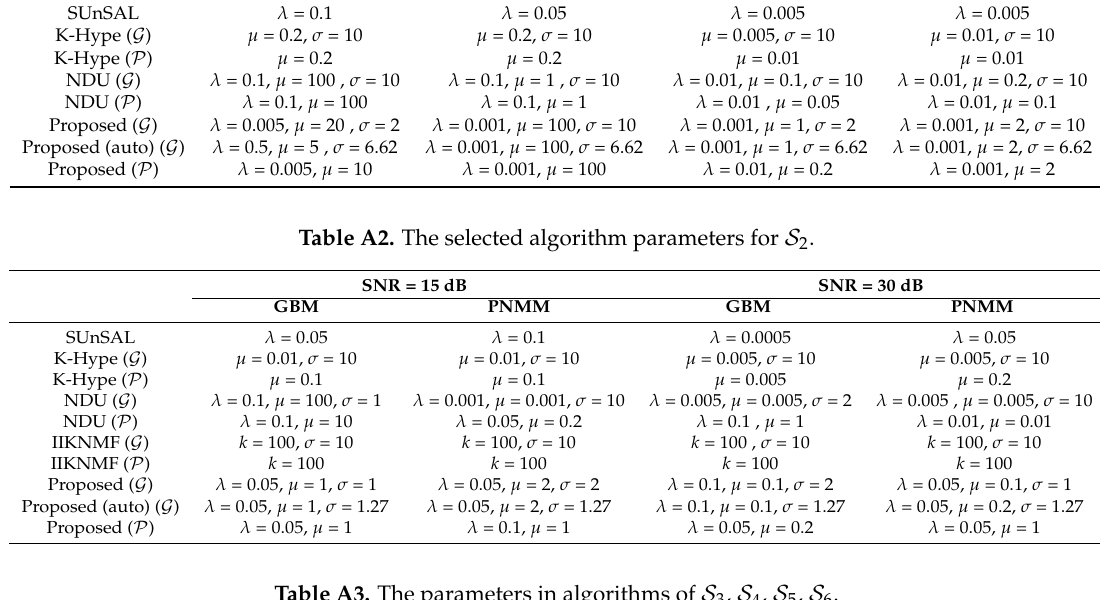
Table A3. The parameters in algorithms of S 3 , S 4 , S 5 , S 6 .